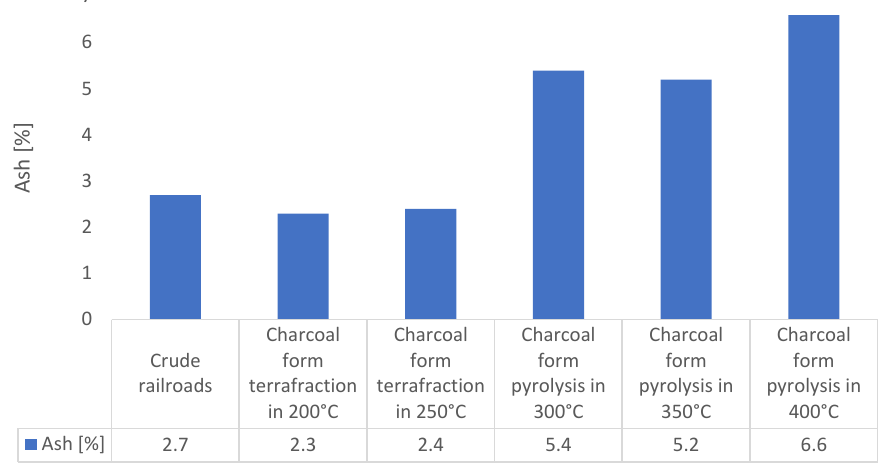
Figure 12. Ash content of raw material (20 °C) and the chars obtained with different final tempera- tures.